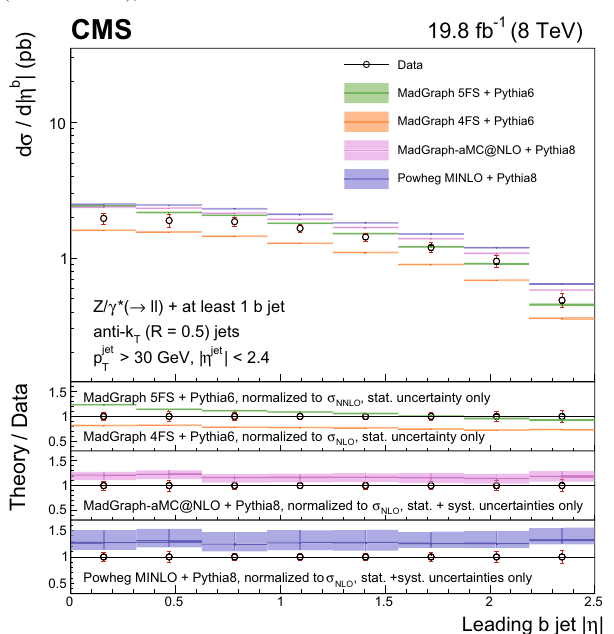
Fig. 5 Differential fiducial cross section for Z(1b) production as a function of the leading b jet | η | ( left ), and the cross section ratio for Z(1b) and Z+jets production as a function of the leading b/inclusive (j) jet | η | ( right ), compared with the MadGraph 5FS, MadGraph 4FS, ( shaded bands ), normalized to the theoretical cross sections described